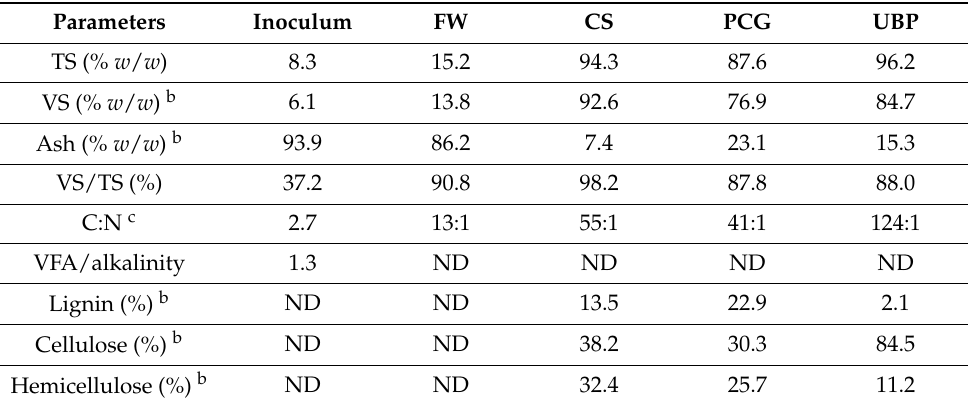
Table 4. The characteristics of inoculum and feedstock a